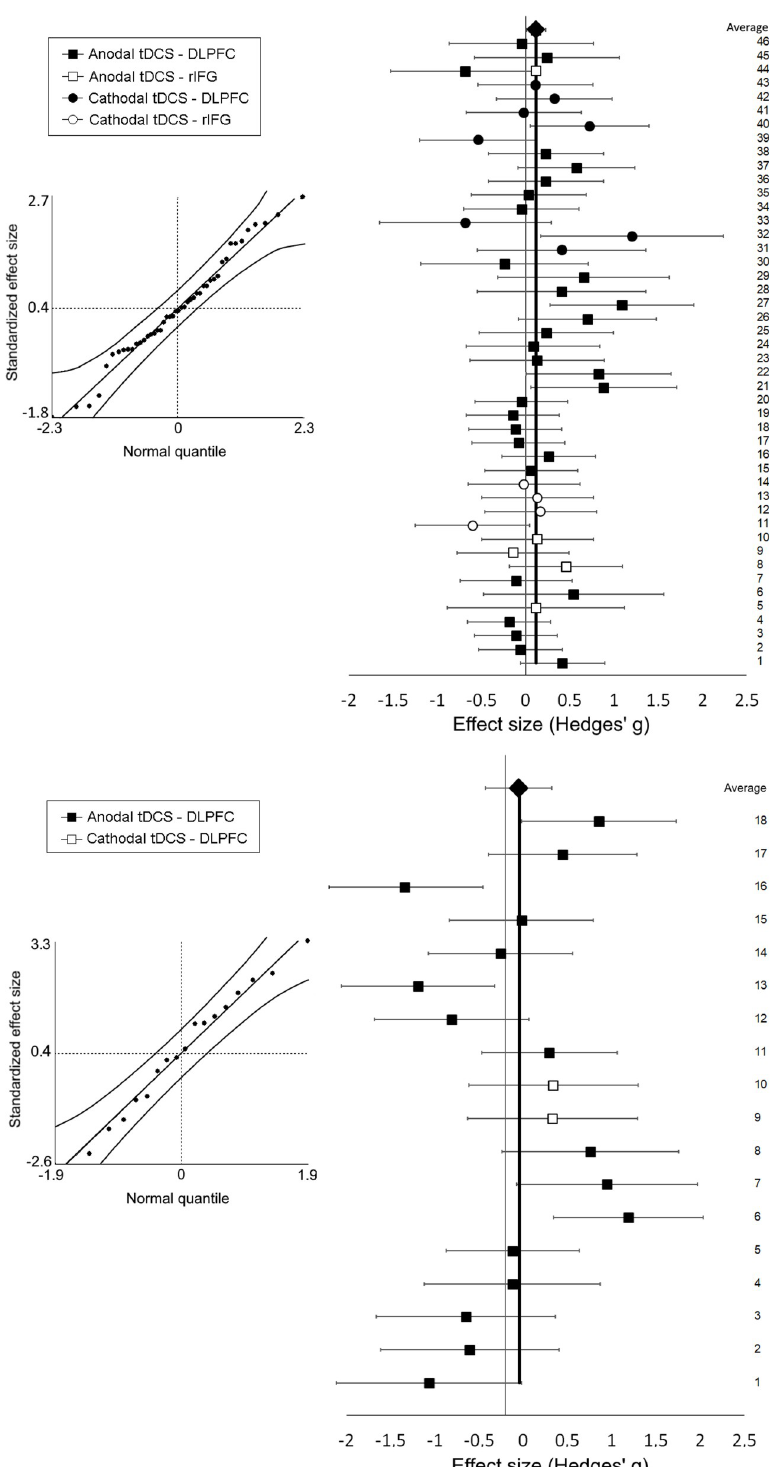
Fig 2. Meta-analysis and forest plot results including Hedges’ g and 95% confidence interval and Cumulative effect size of tDCS on inhibitory control (top) and working memory (down).